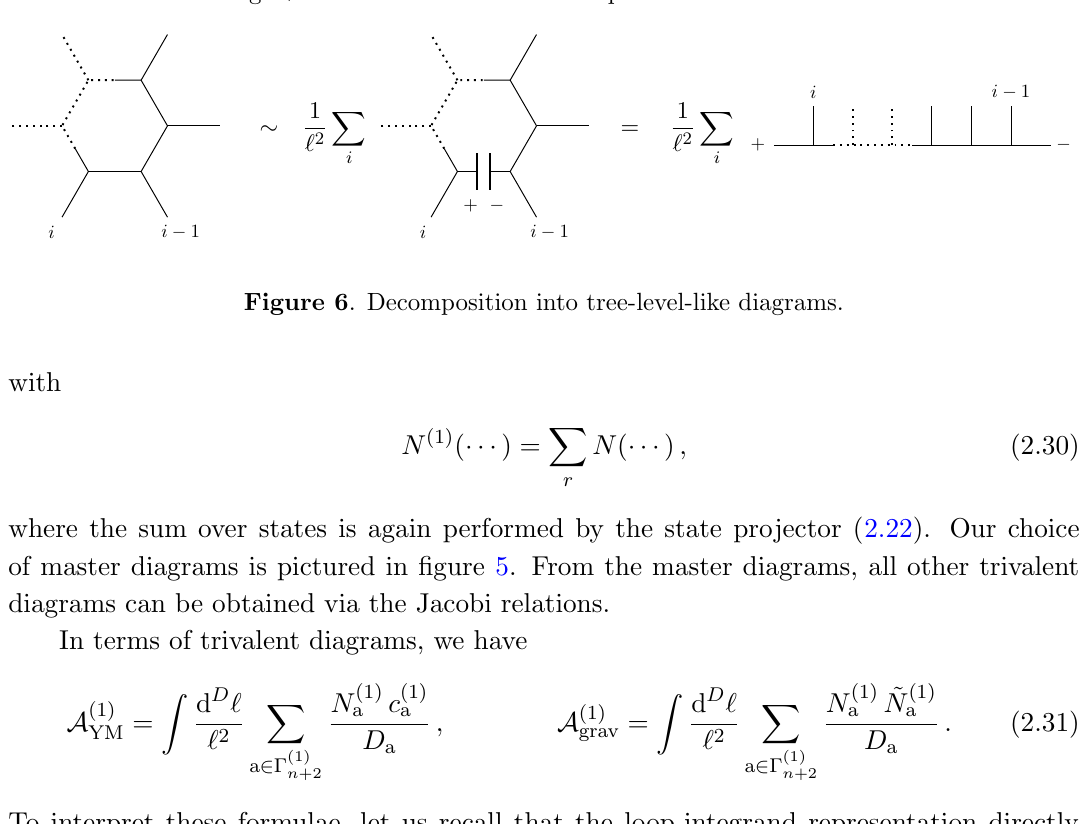
Figure 5 . The one-loop BCJ master diagrams are half-ladder diagrams with (cid:12)xed endpoints, which we choose to be the legs + and (cid:0) associated to the loop momentum.